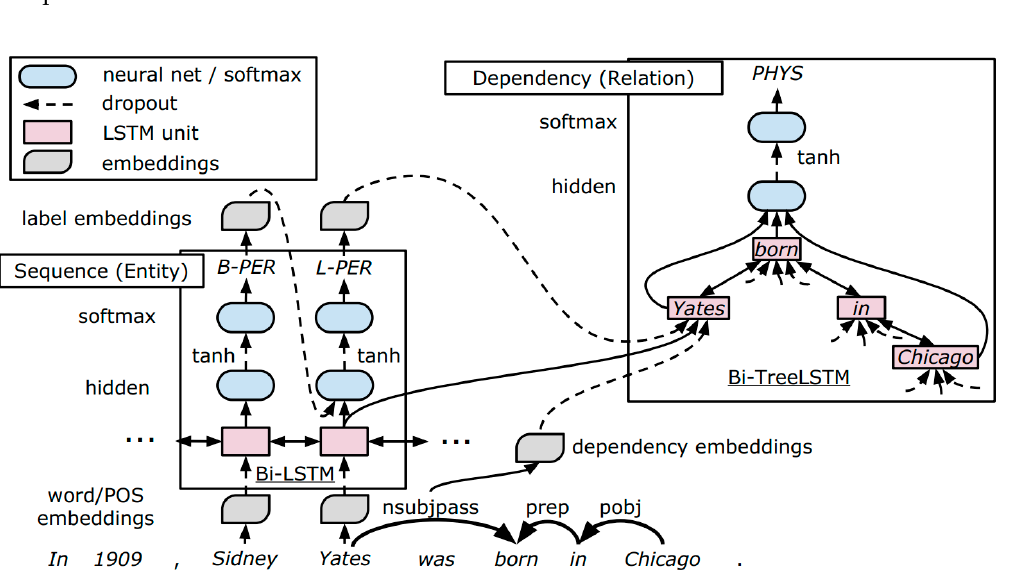
Figure 4. Sequences and tree structures LSTM architecture. Source [23].